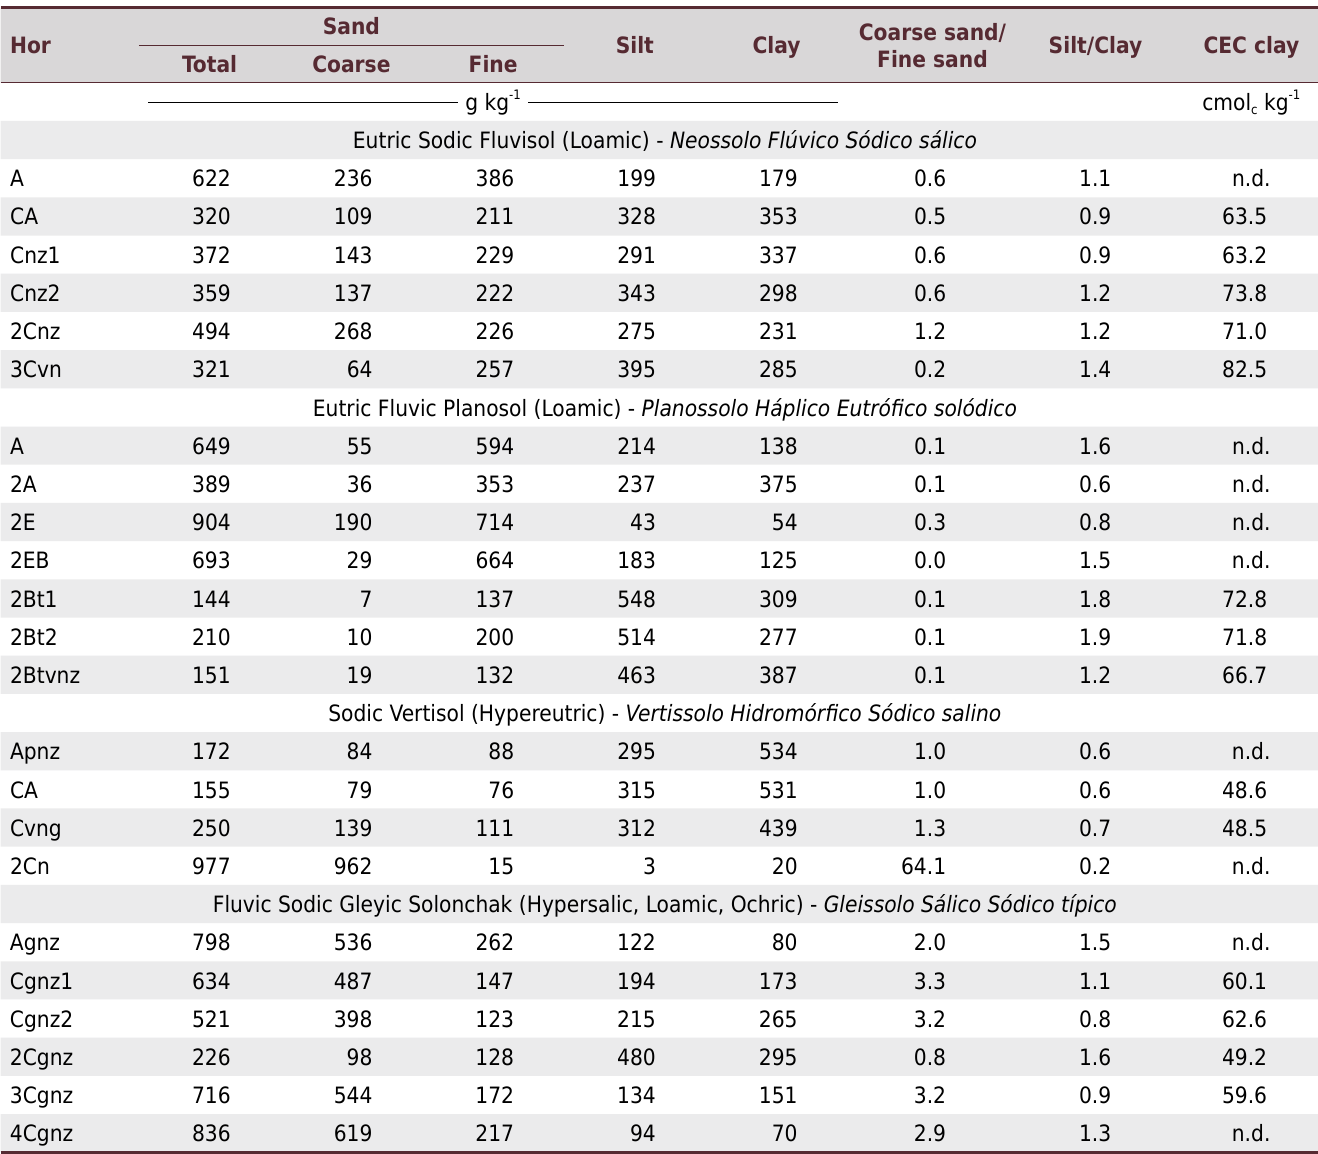
Table 3. Physical properties of soil profiles localized in lower course of the Acaraú River (Ceará State, Brazil) Hor